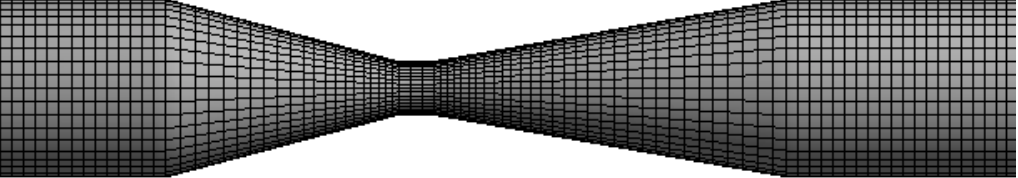
Figure 2. Computational grid. Table 2. Grid independence analysis results.